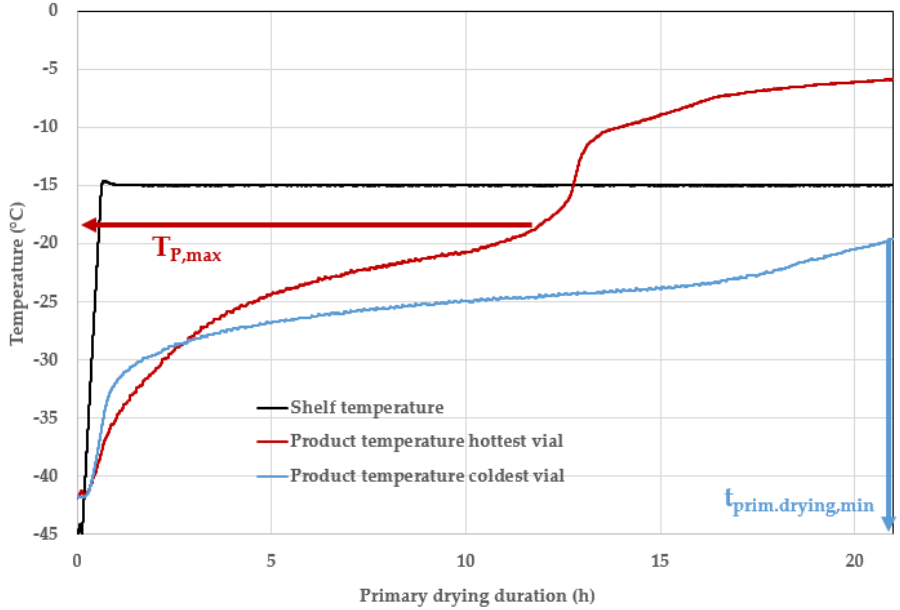
Figure 5. Product temperature variance inside a pilot freeze dryer.